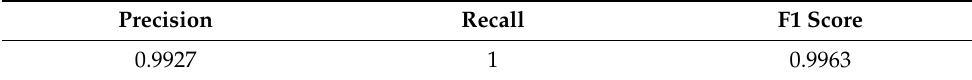
Table 8. Overall results of the classifier. Precision